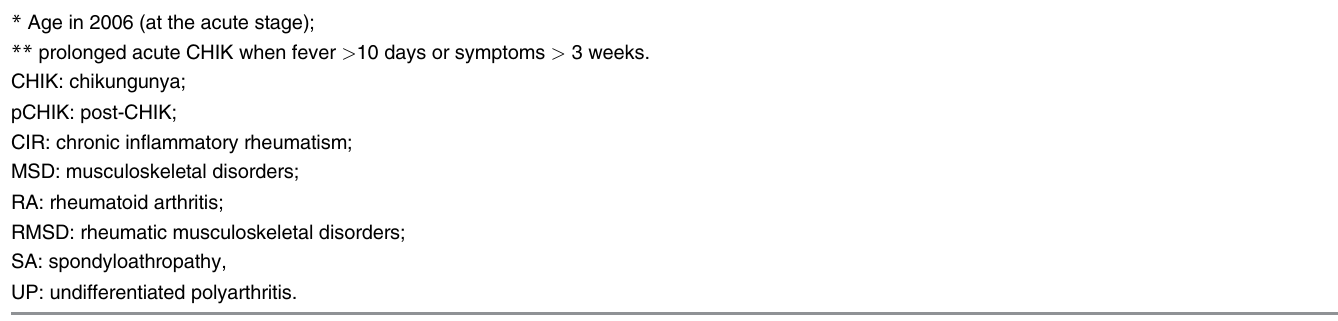
patients with pCHIK-CIR were regularly referred throughout the 6-year period, independent of the type of CIR. plementation. The treatment history and medical features according to the different pCHIK-RMSD are summarized in Tables 3 and 4. The characteristics and specific management of the 43 cases of pCHIK-MSD are shown in Table 5. Only seven patients (15%) responded to the optimal painkiller treatment (using a sec- ond- or third-step analgesic if necessary, with the additional availability of a painkiller in the case of a painful episode). Among the 28 diffuse pCHIK-MSD, 22 consisted of distal polyar- thralgia involving the hands (18 out of 22) and/or the feet (17 out of 22), typically associated with bilateral oedema of the extremities (about 50% of cases). This feature was frequently com- plicated by carpal or tarsal tunnel syndromes and paraesthesia that responded to a short course of corticotherapy (oral and/or injected into the joint) and sometimes improved with neuro- pathic pain medication, when indicated. Five patients with diffuse pCHIK-MSD (18%) re- ceived hydroxychloroquine without a self-reported benefit, while 20 out of 28 (70%) were efficiently treated with oral corticosteroids (16 out of 20 had a successful withdrawal of system- ic corticotherapy without clinical relapse). Loco-regional pCHIK-MSD primarily involved proximal joints. In 11 cases, pCHIK-MSD presented as exacerbated pain in previously involved